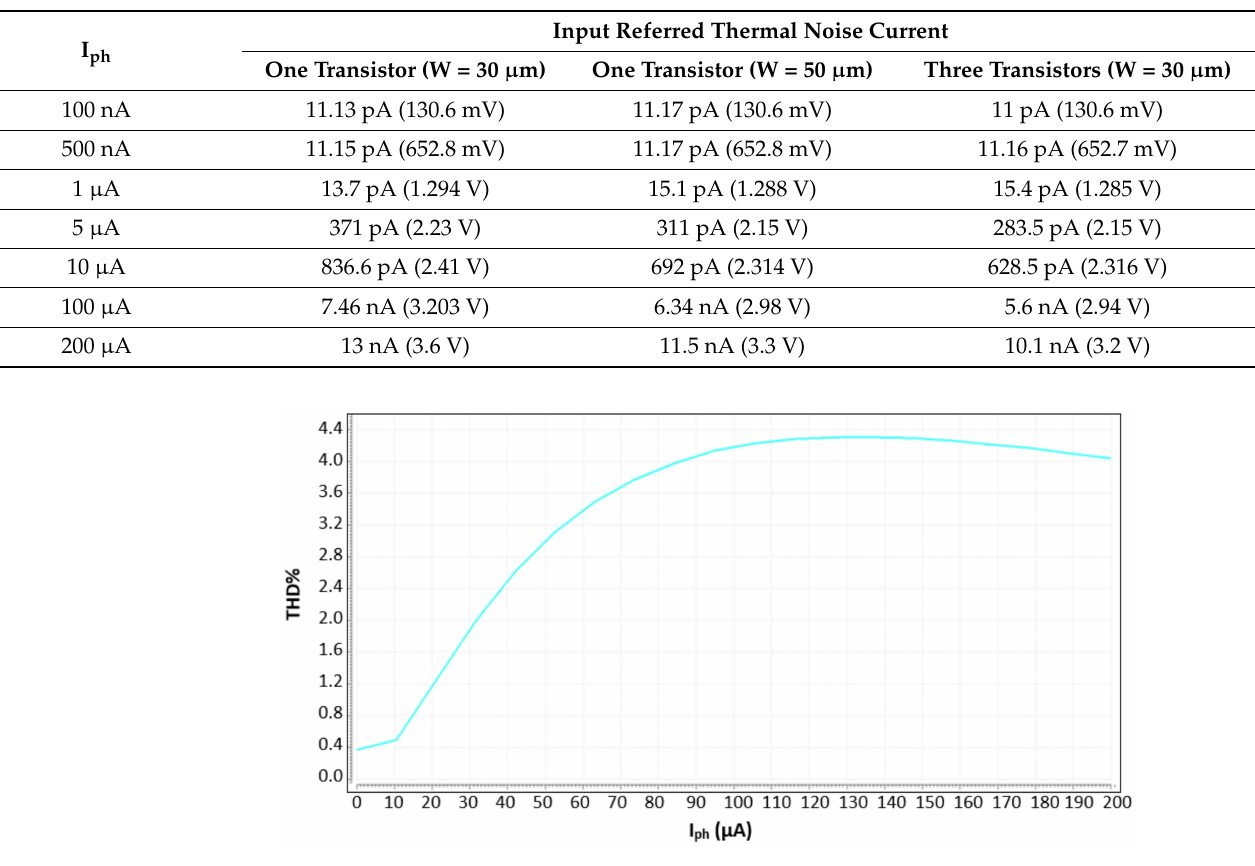
Figure 7. The total harmonic distortion for different